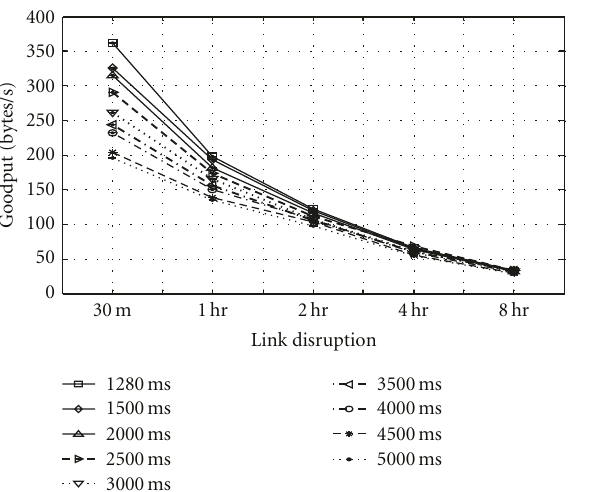
Figure 3: Comparison of number of retransmissions for DTN transmissions over cislunar channels with link disruption at a BER of 10 − 5